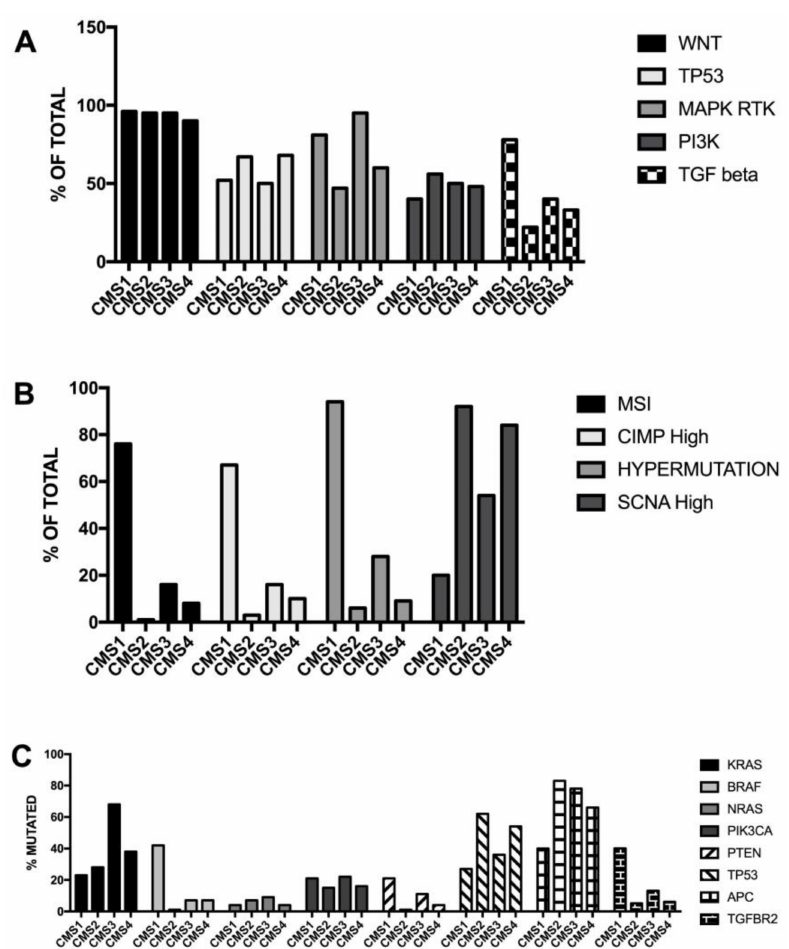
Figure 9. Gene expression-based classification of colorectal cancers into four types according to Guinney et al. [251]: consensus molecular subtype 1 (CMS1), CMS2, CMS3 and CMS4. ( A ): Activation of some signaling pathways in the four CMS subtypes. ( B ) Distribution of some molecular abnormalities in the four CMS subtytes. ( C ): Recurrent gene mutations in the four CMS subtypes. CIMP: CpG island methylator phenotype; hypermutation; SNCA high: single copy number alteration